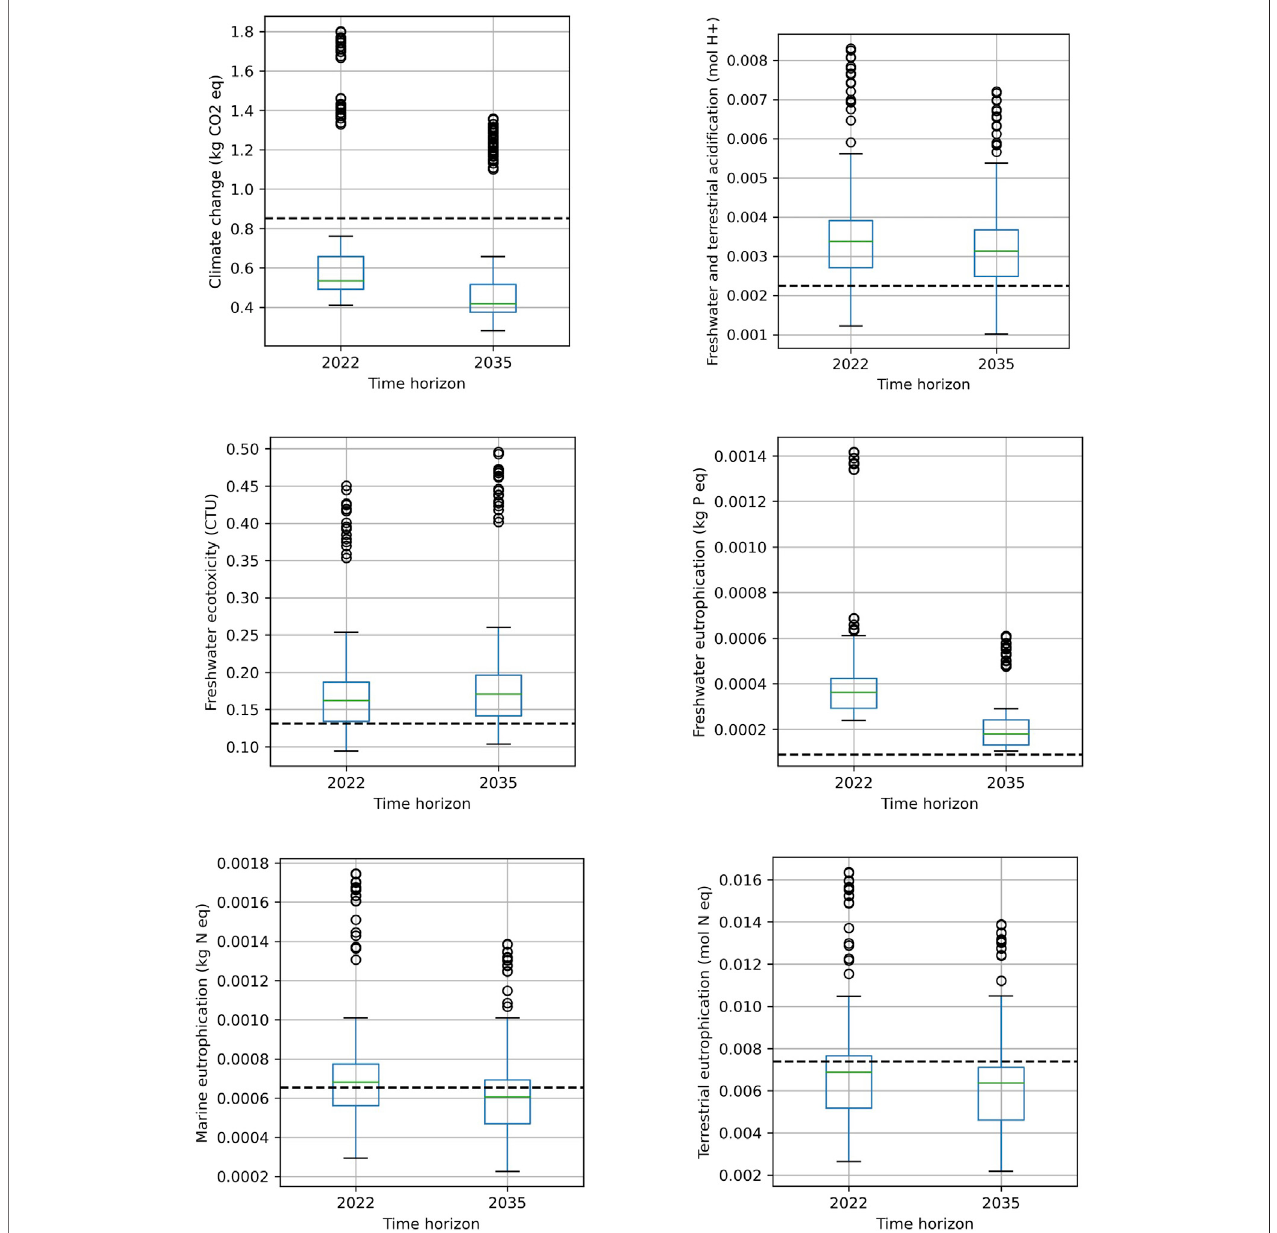
FIGURE 3 | Scenarios distribution for midpoint impacts on the ecosystem with the two production time-horizons — the dashed line shows the impact of 1 kg of Portland cement.